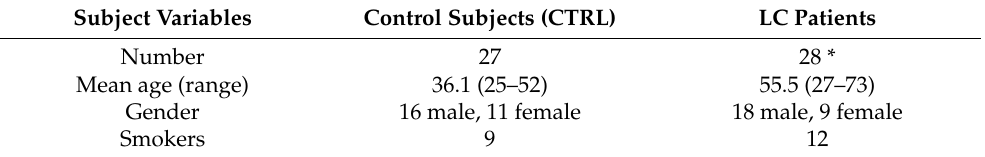
Table 1. Characterisation of the subjects recruited in terms of number, age, gender, and smoking